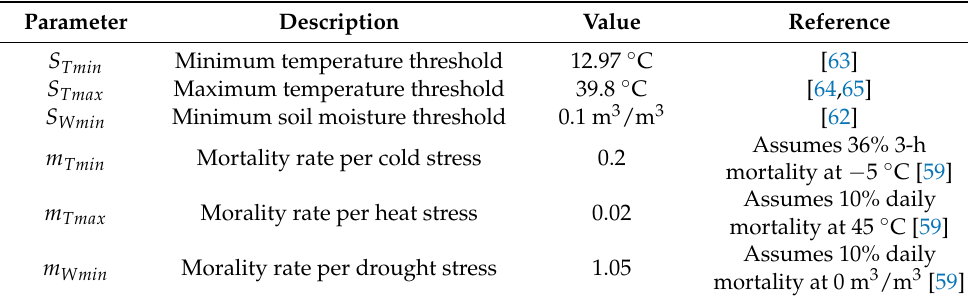
Table 2. The environmental thresholds and mortality parameters of